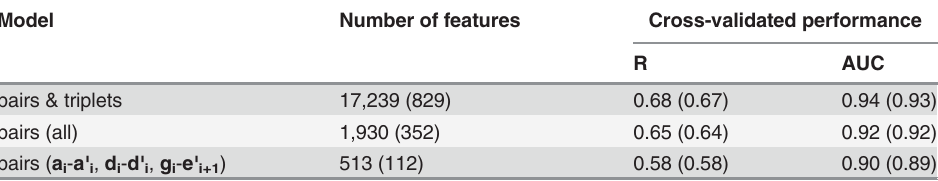
Table 2. Performance of predictive models using different sets of residue